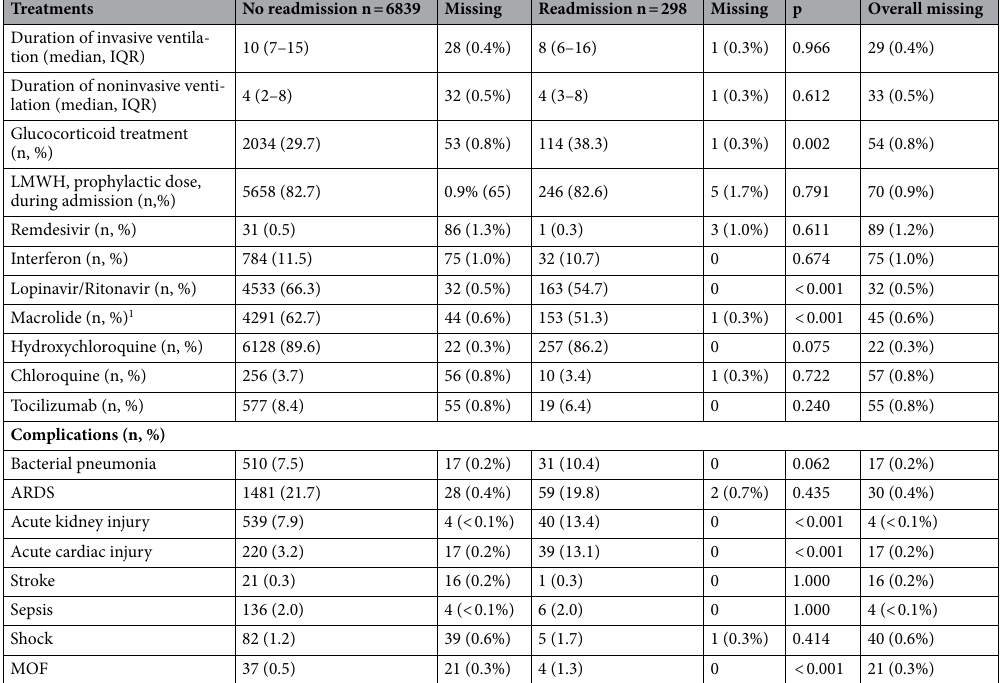
Table 2. Treatment, complications, and progress of patients with COVID-19 depending on hospital readmission. LMWH: Low-molecular-weight heparin, ARDS: acute respiratory distress syndrome, MOF: patterns.